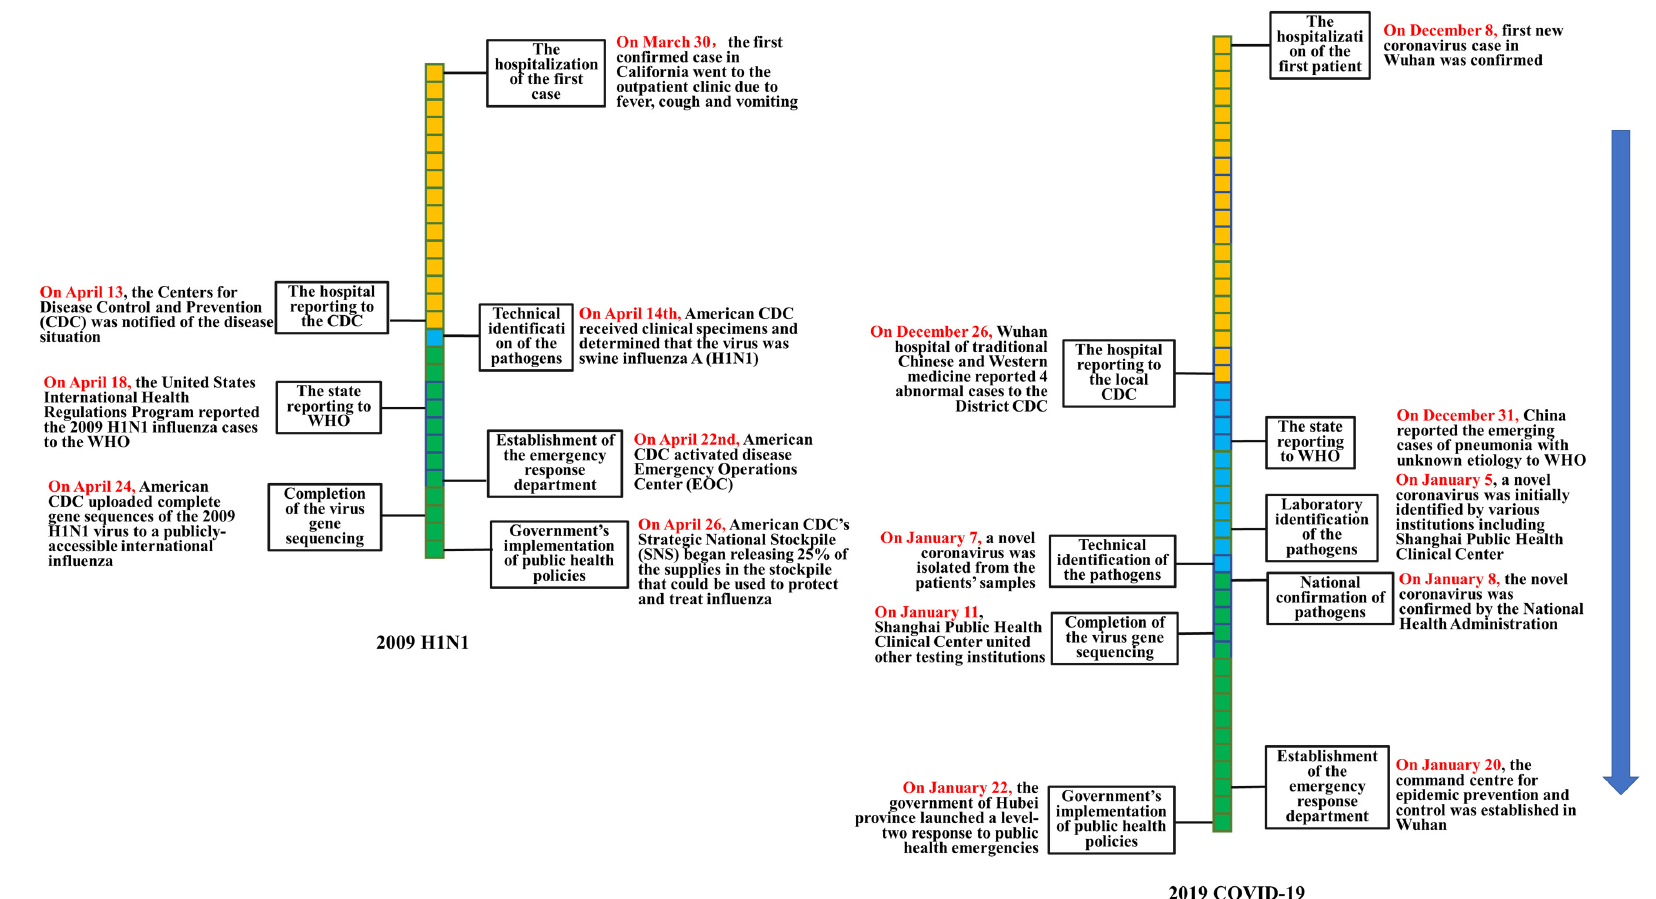
Figure 1. Comparison of the emergency disposal timeline of H1N1 swine influenza (2009) and COVID-19 (2019).